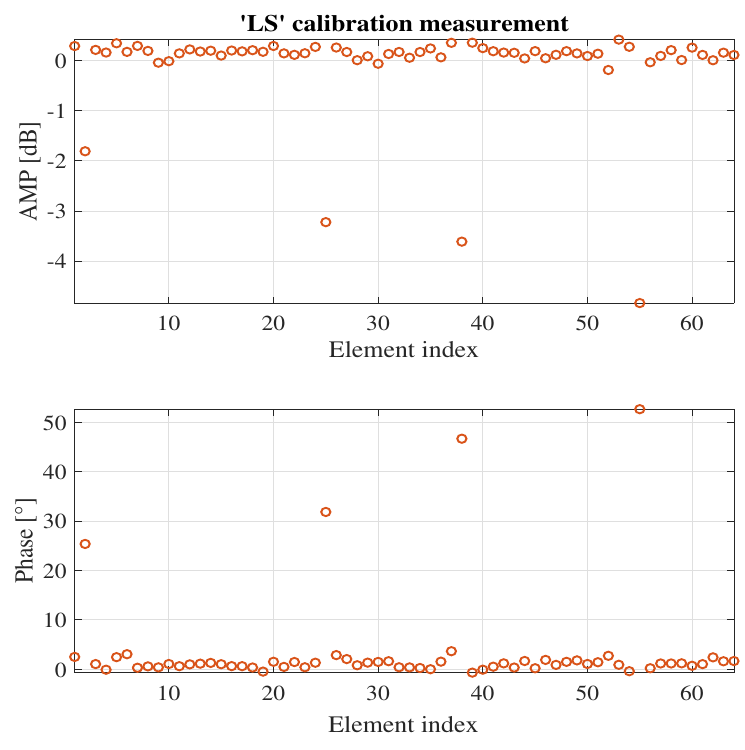
Figure 11. ‘Least squares’ calibration effectiveness measurement